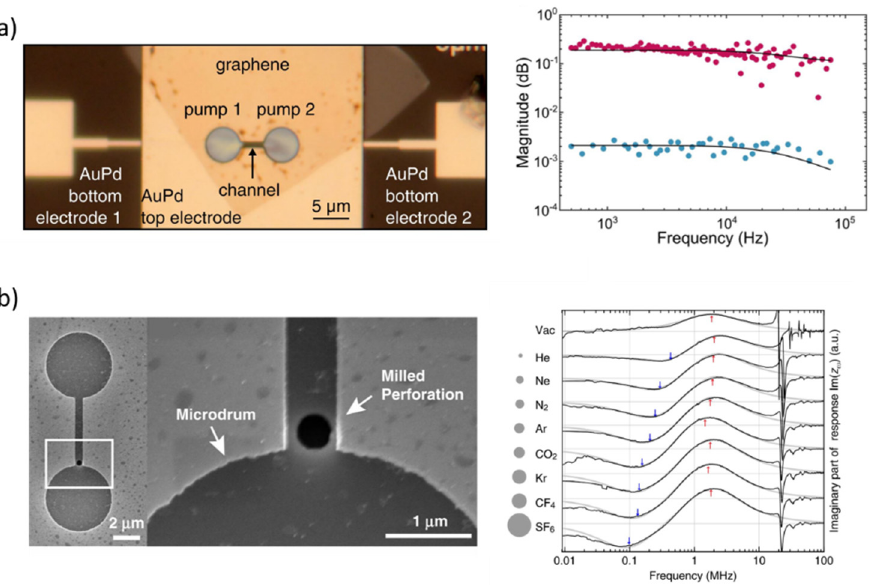
Figure 7. Graphene drum resonators for pneumatic testing. ( a ) Graphene gas pumps [87] and ( b ) graphene drum with a milled nanopore [88].